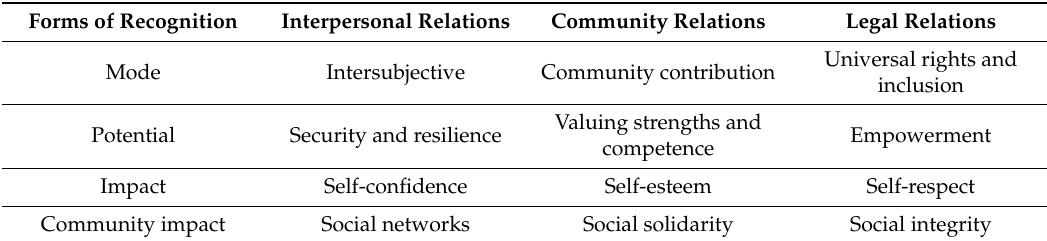
Table 1. Honneth’s Theory of Recognition